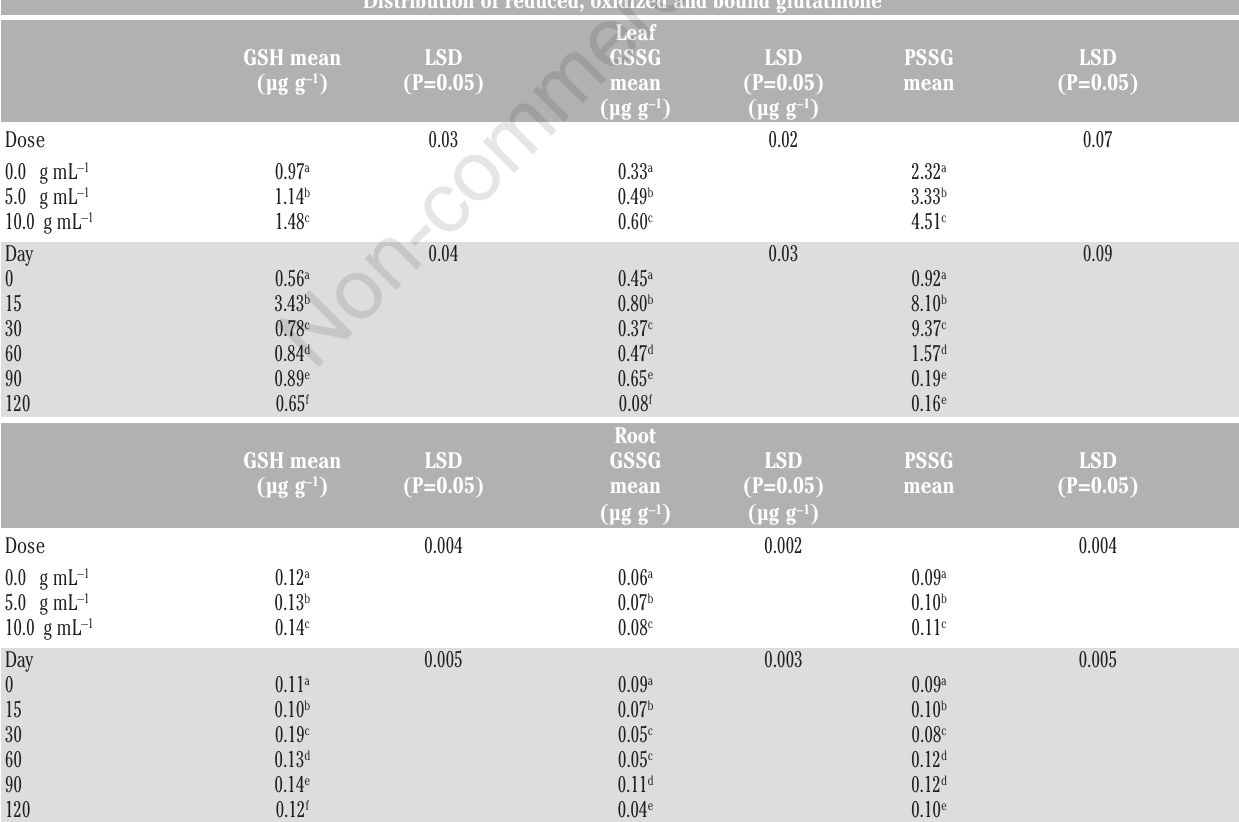
Table 1. Means and least significant differences (P=0.05) of the concentration distribution of GSH, GSSG and PSSG in leaf and root at predetermined intervals following application of SA at 5.0 and 10 (cid:0)g mL –1 . Distribution of reduced, oxidized and bound